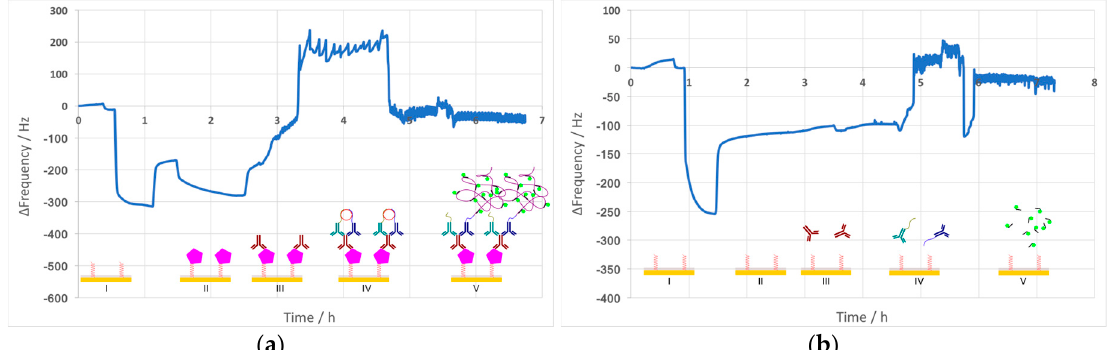
Figure 3. Sensograms of sandwich-type PLA in continuous flow. The inset figures depict the actual assay step, corresponding to the sensogram part. I—aptamer functionalization & blocking, II— NoVLPs or PBS, III—primary Ab, IV—PLA probes & ligation, and V—amplification. ( a ) Sensogram of the assay with 4.7 nM NoVLPs in order to perform the sandwich PLA to achieve bulky RCPs; ( b ) Sensogram of the assay without introducing any NoVLPs into the system (negative control with